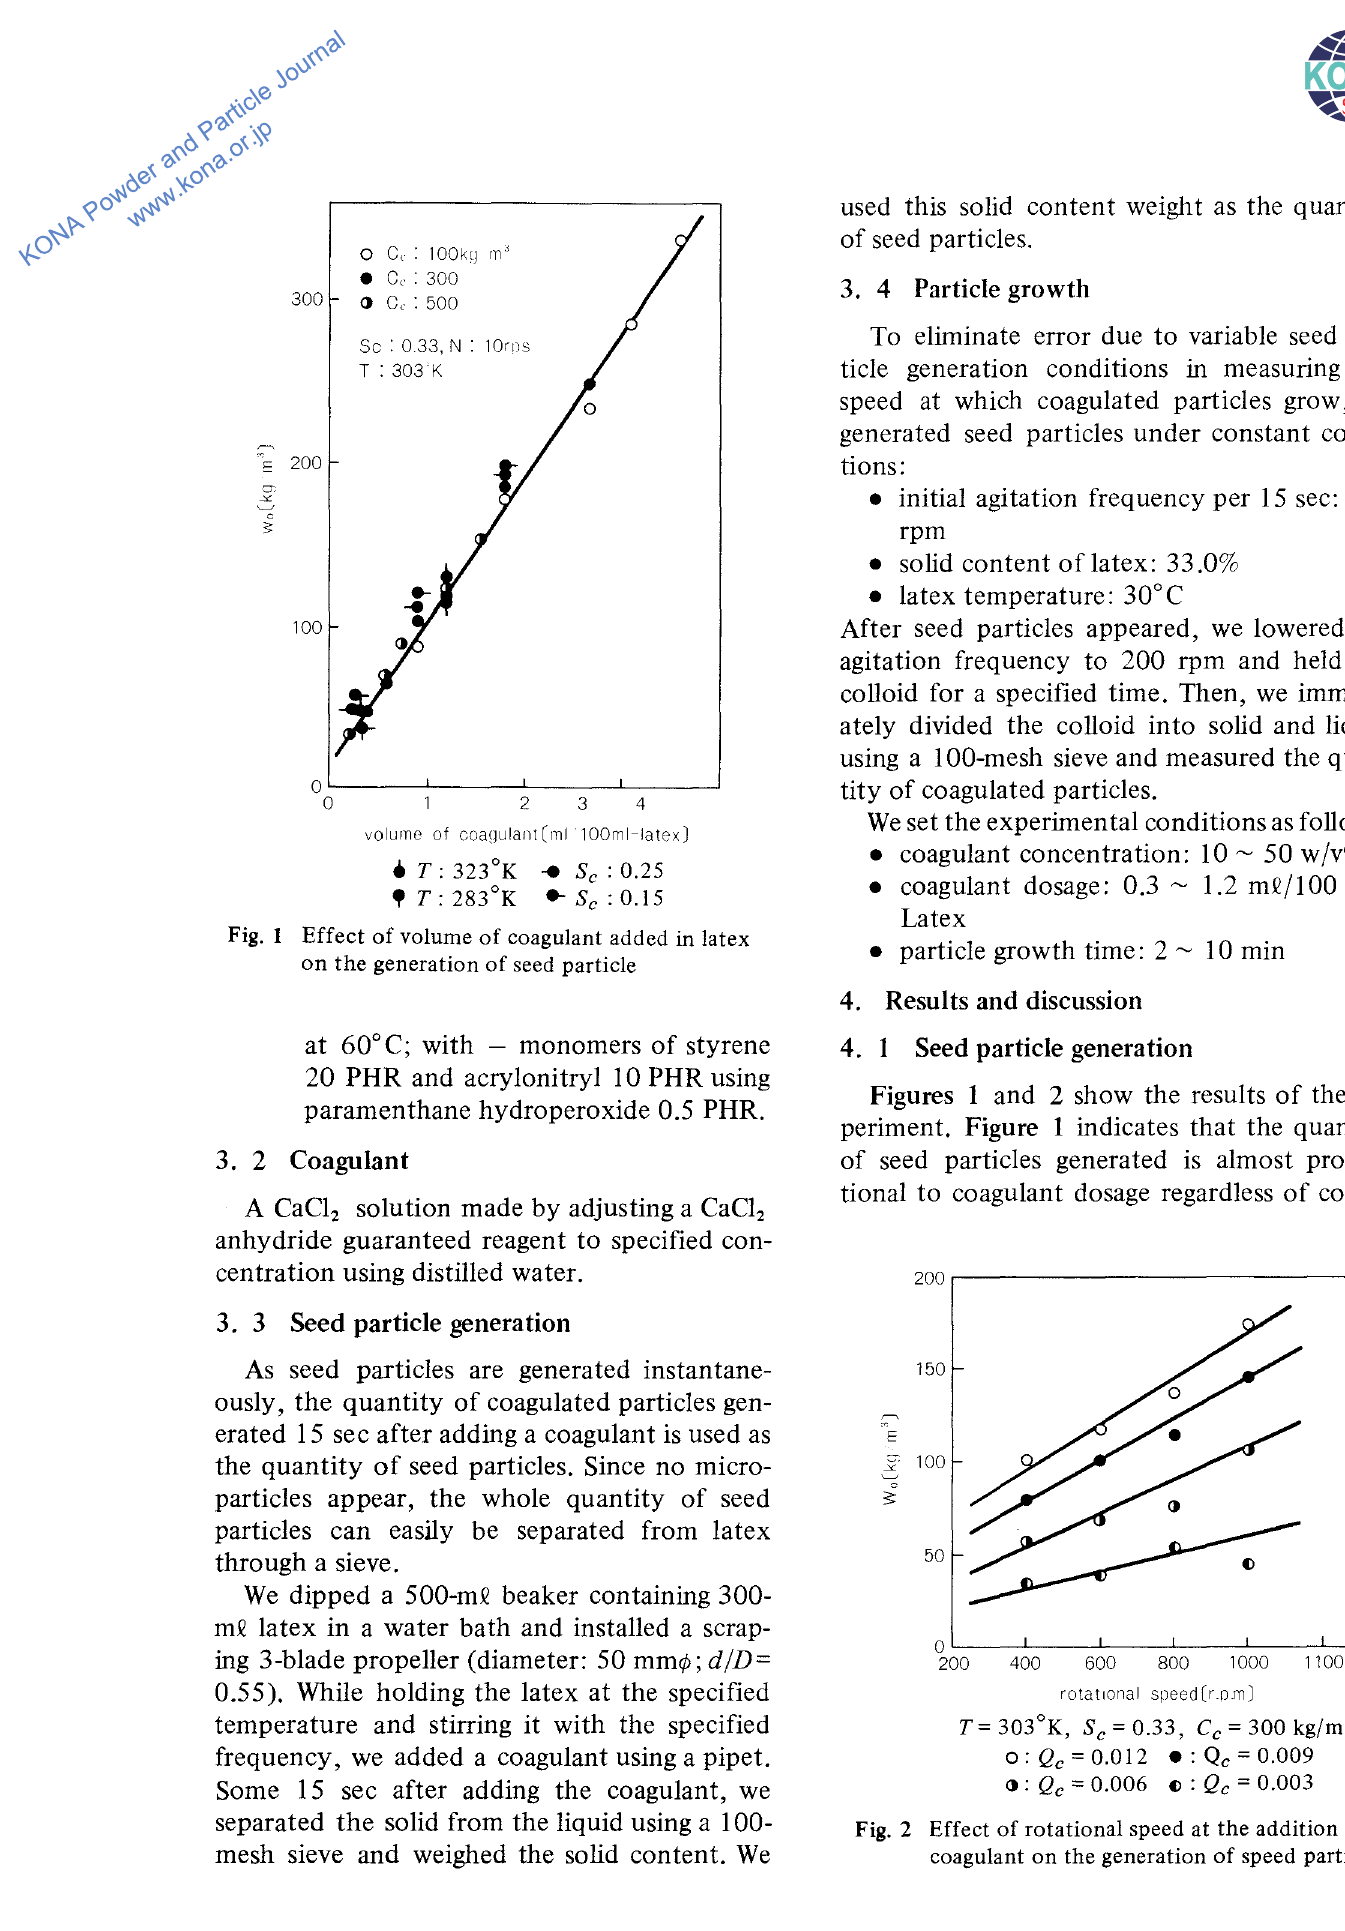
Fig. 2 Effect of rotational speed at the addition of coagulant on the generation of speed